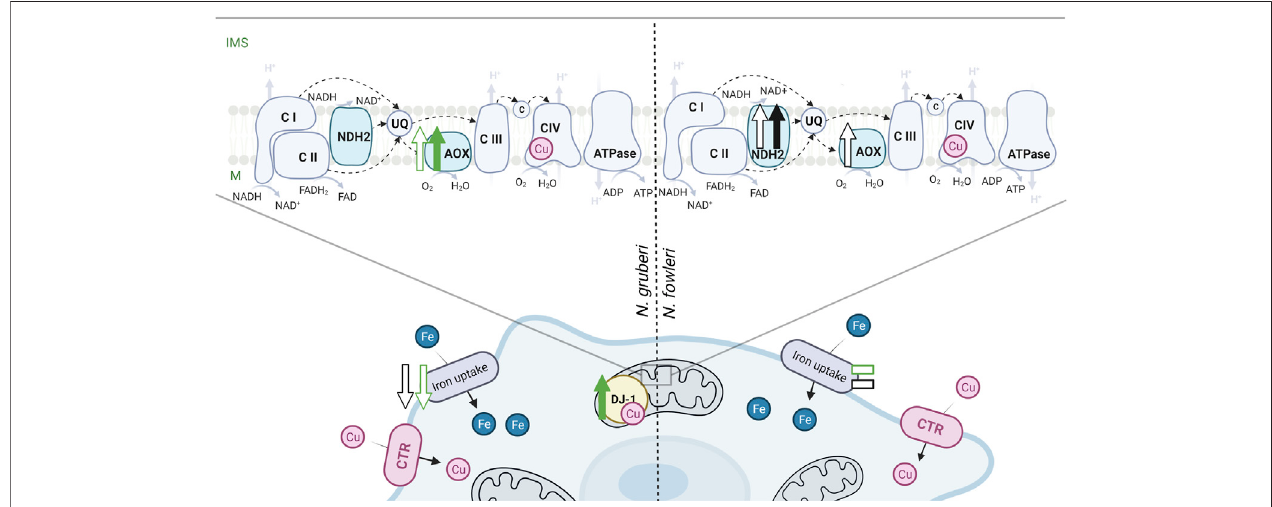
FIGURE 6 | The main effect of copper deprivation on the cellular processes of N. gruberi and N. fowleri . The green color corresponds to the effect of the copper chelator BCS, and changes caused by neocuproine are depicted in black. Upward pointing arrows represent an increase in copper-deprived conditions, downward pointing arrows denote a decrease in copper-deprived conditions, and dashes indicate no copper-induced changes. Full arrows represent the results from the proteomic analysis, and empty arrows represent the measured activity. Respiration chain complexes are marked by appropriate numbers, UQ – ubichinol/ ubichinone, c – cytochrome c. Created with